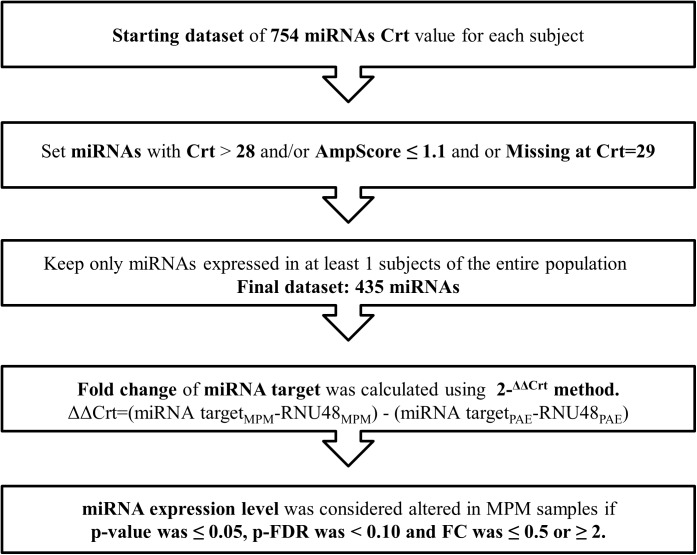
Data processing workflow.